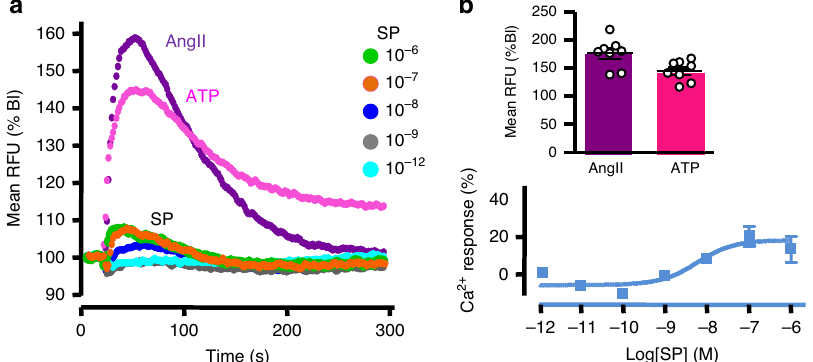
Fig. 4 Effect of substance P on the calcium signalling pathway in cultured adrenocortical cells. a Effect of SP (from 10 − 12 to 10 − 6 M), angiotensin II (Ang II; 10 − 6 M) and ATP (10 − 5 M) on cytosolic calcium concentrations in cell pools (RFU relative fl uorescence unit). Data are normalised to basal level (Bl) and expressed as mean of three culture dishes (triplicate). Recordings are representative of n = 3 independent cultures. b Maximum amplitude of Ang II- and ATP-triggered calcium responses (upper panel). Data are presented as mean ± SEM of eight cultures dished examined over three independent experiments. CI 95% were 154 – 197 and 129 – 160 for Ang II and ATP, respectively. Lower panel: dose-response curve of SP-induced maximum calcium responses normalised to those of Ang II illustrated in panel a Surprisingly, aprepitant potentiated the aldosterone secretion plasma aldosterone level in recumbency (322 ± 31 versus 239 ± induced by metoclopramide, a serotonin receptor type 4 receptor 17 pmol L − 1 ; p = 0.04; Fig. 6e, f). In addition, aprepitant had no agonist ( p = 0.002; two-way ANOVA, Supplementary Discussion; in fl uence on plasma renin ( p = 0.12), potassium levels ( p = 0.12) Supplementary Fig. 11). and blood pressure (Fig. 6g; Supplementary Figs. 9 and 10).